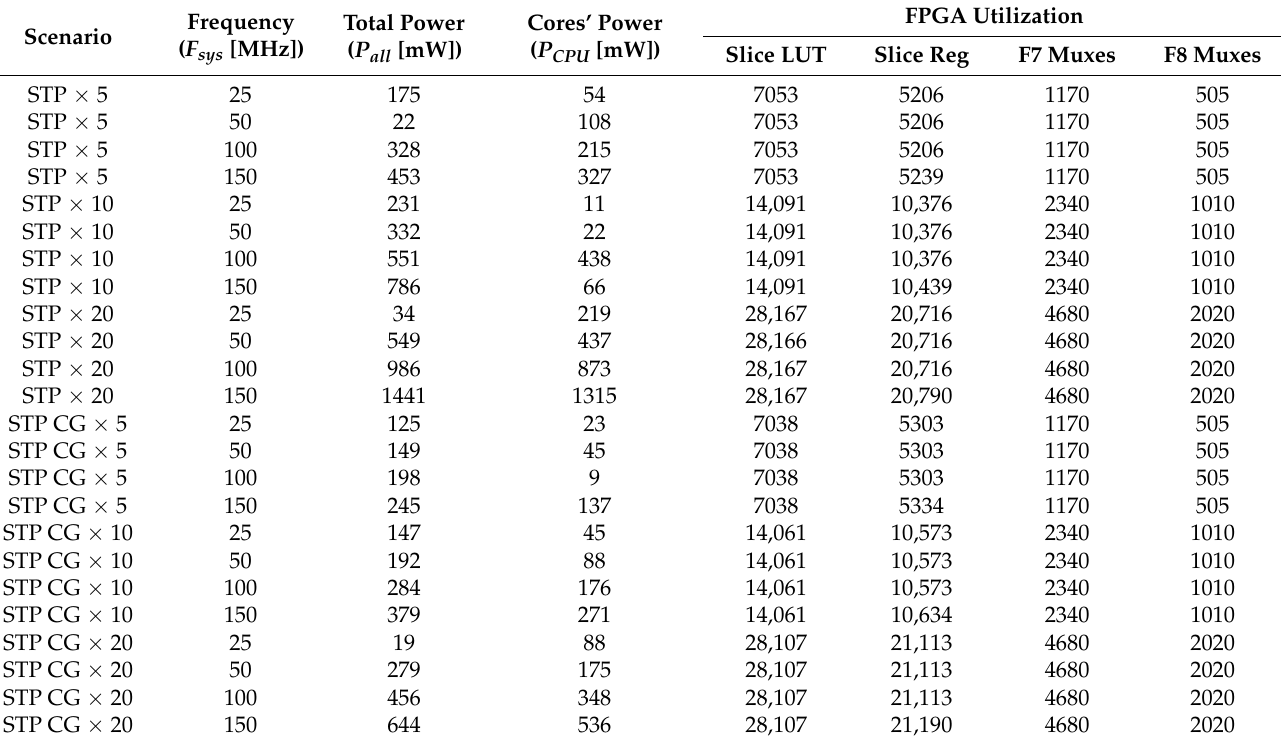
Table 1. Average results of the experiments with the simple architectures